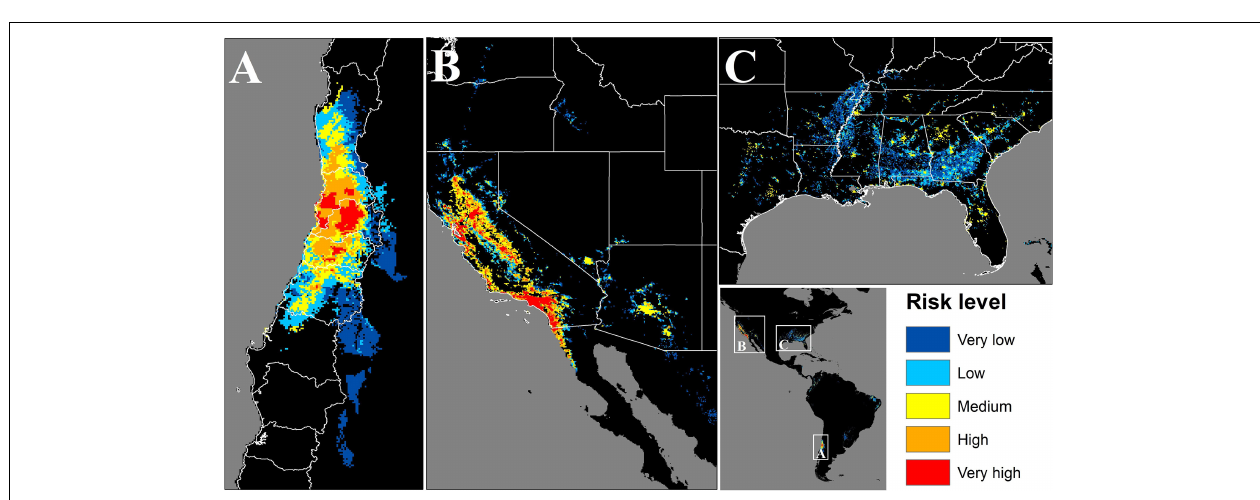
FIGURE 3 | Map of the distribution of C. bacillisporus predicted by MaxEnt niche modeling in South (A) and North America (B) .